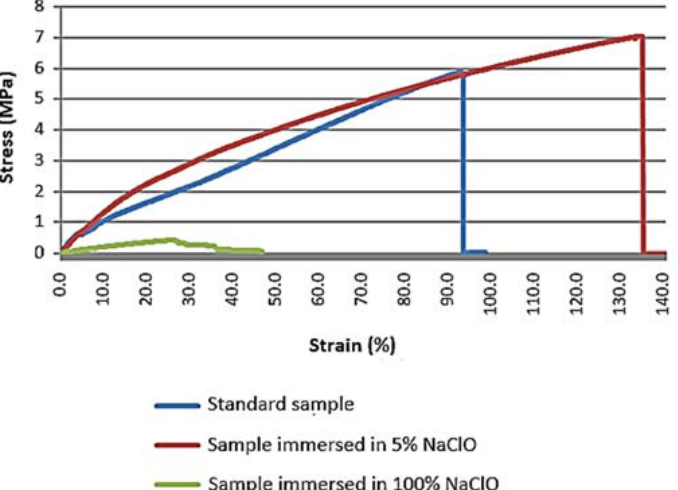
Figure 13. Stress-strain graph of the beech tensile test for the standard sample and samples immersed for three weeks in 5% and 100% NaClO.